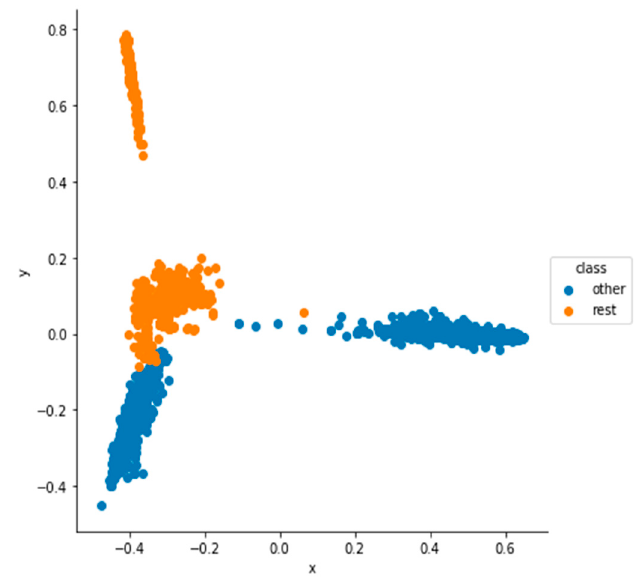
Figure 5. Result using the FPSR method.